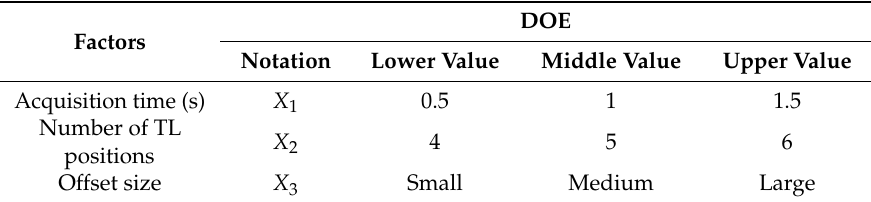
Table 3. Factors used in the design of experiment (DOE)